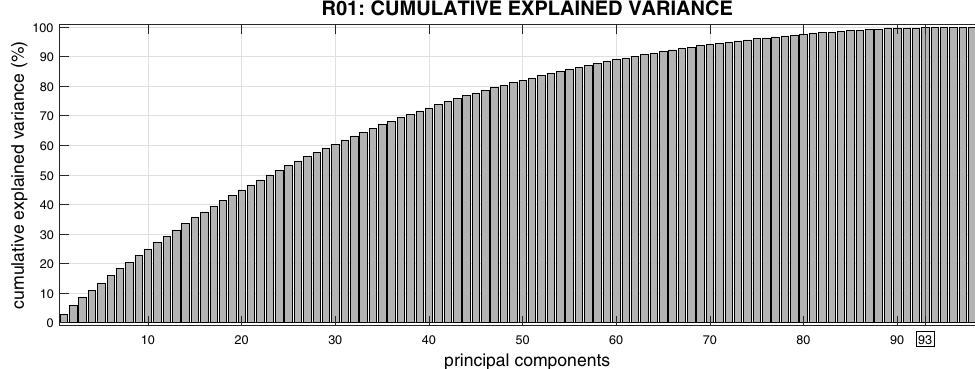
Figure 5. Cumulative explained variance in function of principal components. 93 principal components were selected in the tests, which explain about the 99% of the variance of the training set.